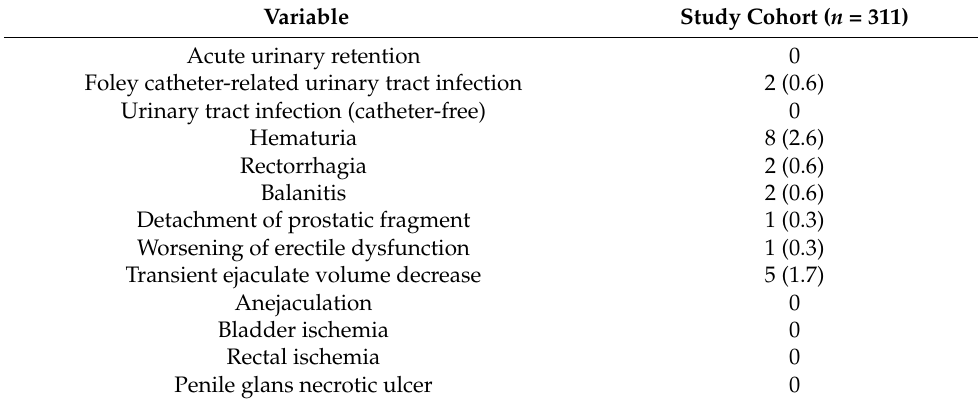
Table 4. Embolization-related adverse events.